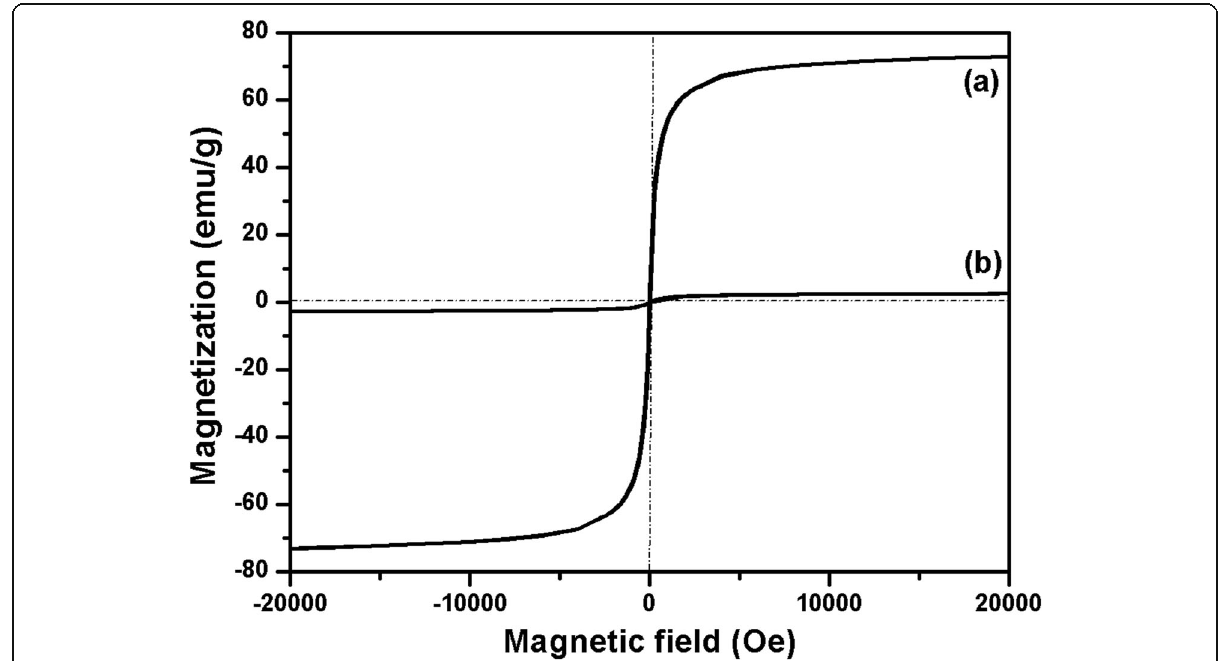
Fig. 3 Room temperature magnetic hysteresis curves of ( a ) Fe 3 O 4 , and ( b ) FOSTA composite